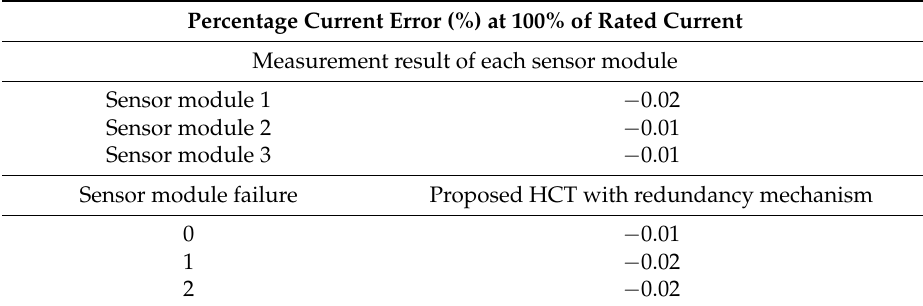
Table 7. Current errors of the proposed HCT when three-phase currents are